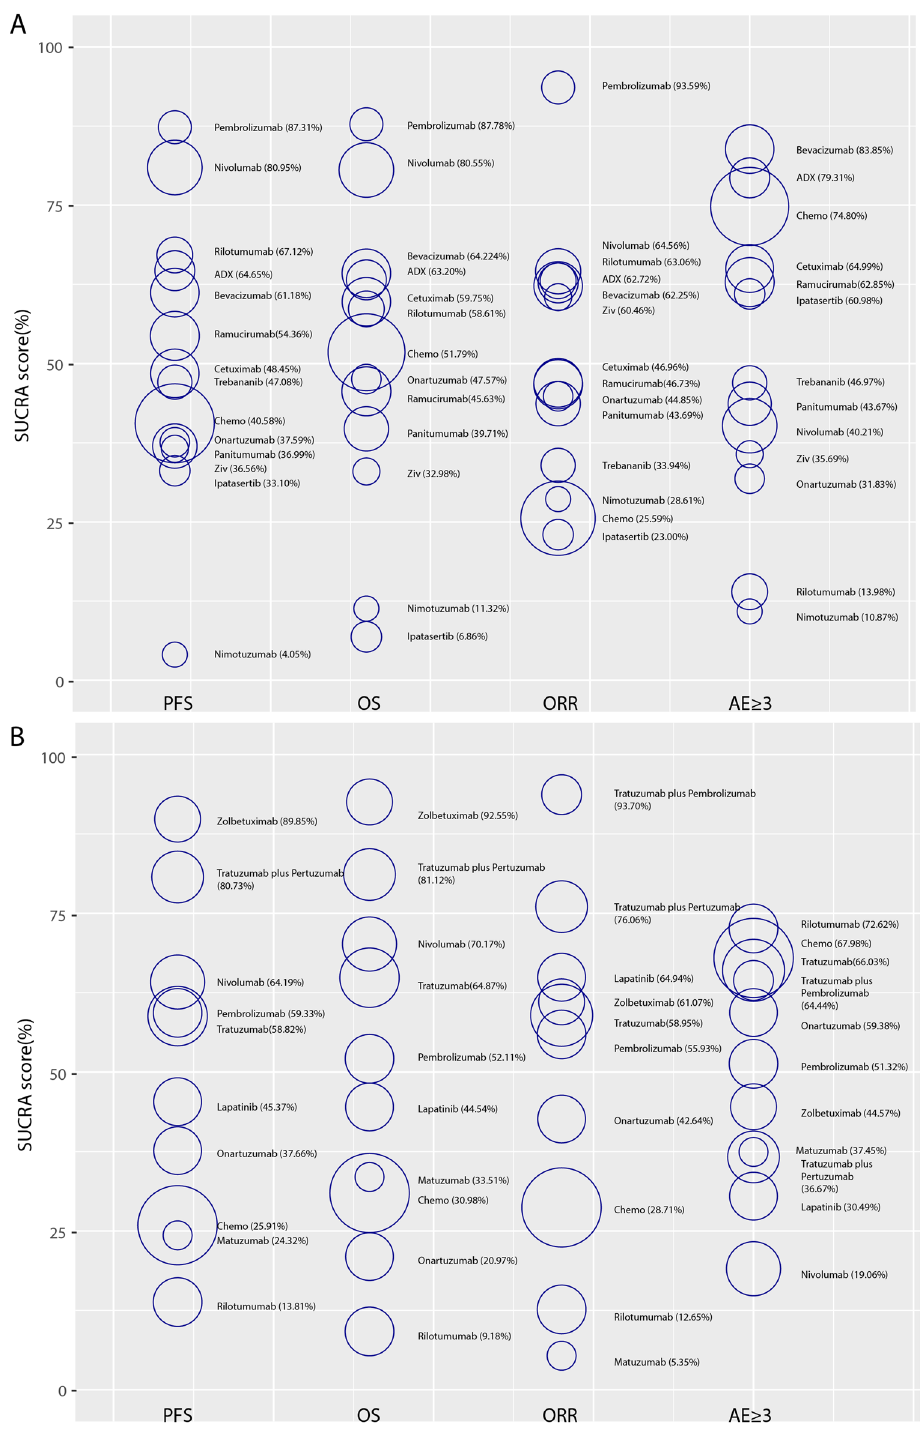
Figure 6. SUCRA score of each regimen in all outcomes. ( A ) SUCRA score in average group; ( B ) SUCRA score in specific positivity group. The size of each circle is weighted by the square root of the patient number. All regimens are combined with chemotherapy, ADX: Andecaliximab; Ziv: Ziv-aflibercept; Chemo: